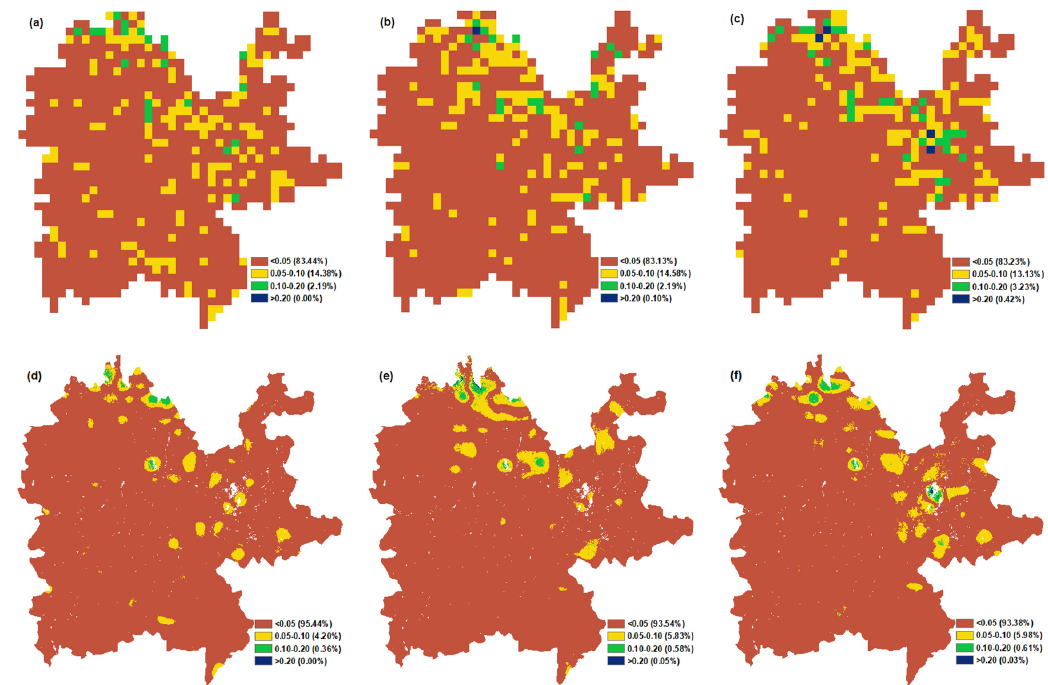
Figure 7. The residuals contribution (RC) maps at coarse resolution (NDVI ( a ), EVI ( b ), and LAI ( c )) and fine resolution before residual correction (NDVI ( d ), EVI ( e ), and LAI ( f )) for the year 2018. RC maps at coarse resolution calculated as the absolute values of residual maps (Figure 6a–c) divided by original TRMM (Figure 5a), similarly, at the fine resolution, it calculated as the absolute values of residual maps (Figure 6d–f) divided by the corresponding downscaled TRMM maps (Figure 8a–c).